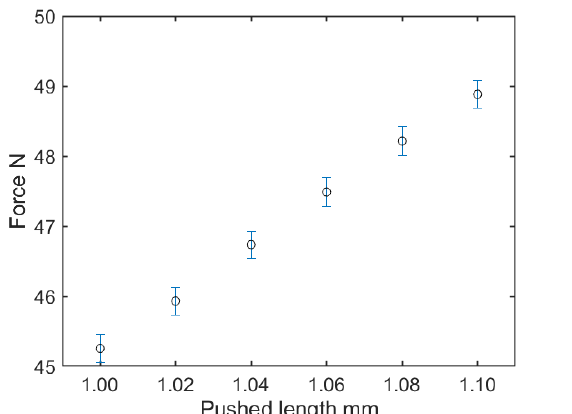
Figure 6. Relationship between the pushed length and the force of S43. Table 4. Mean and standard deviations of the force at each pushed length and mean of the difference in force caused by